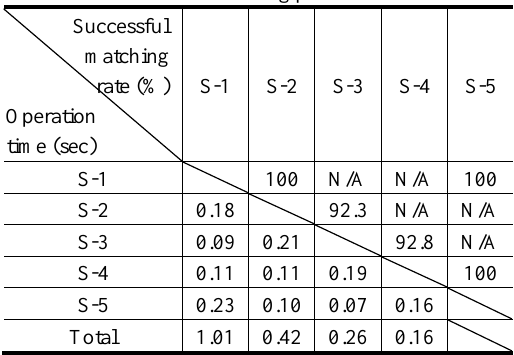
Table 2. the matching performances.